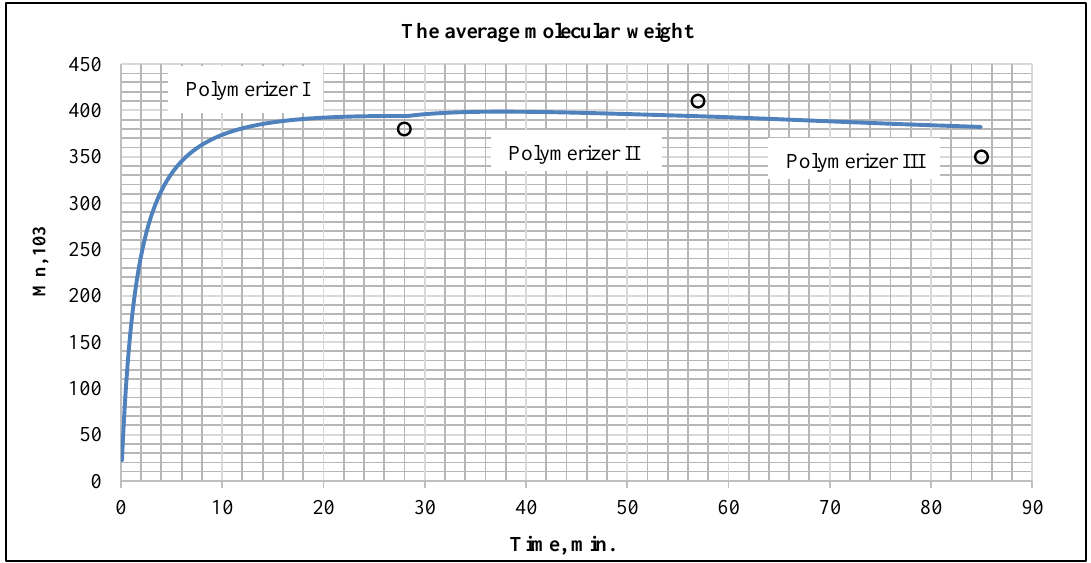
Figure 7. The dependence of the calculated average molecular weight on time for polyisoprene on the catalytic system 𝑵𝒅𝑪𝒍 𝟑 -nIPA-TIBA-Pip (line denotes the results of calculations, dots show the results of a laboratory experiment).